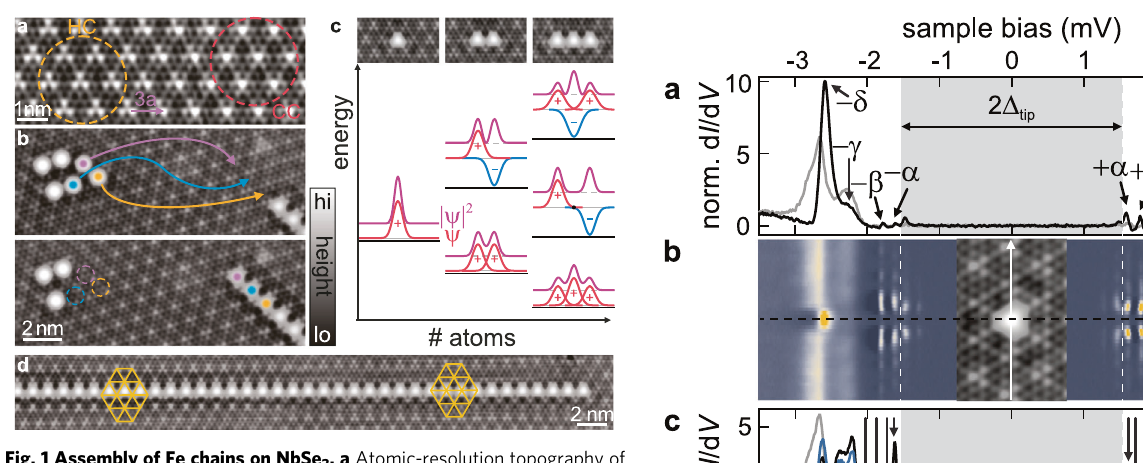
Fig. 1c). Successively placing Fe atoms at a distance of 3 a (Fig. 1b), we fi nd that chains with up to about ten adatoms remain essentially uniform. Longer chains become inhomoge- neous due to the incommensurate nature of the CDW (Fig. 1d).